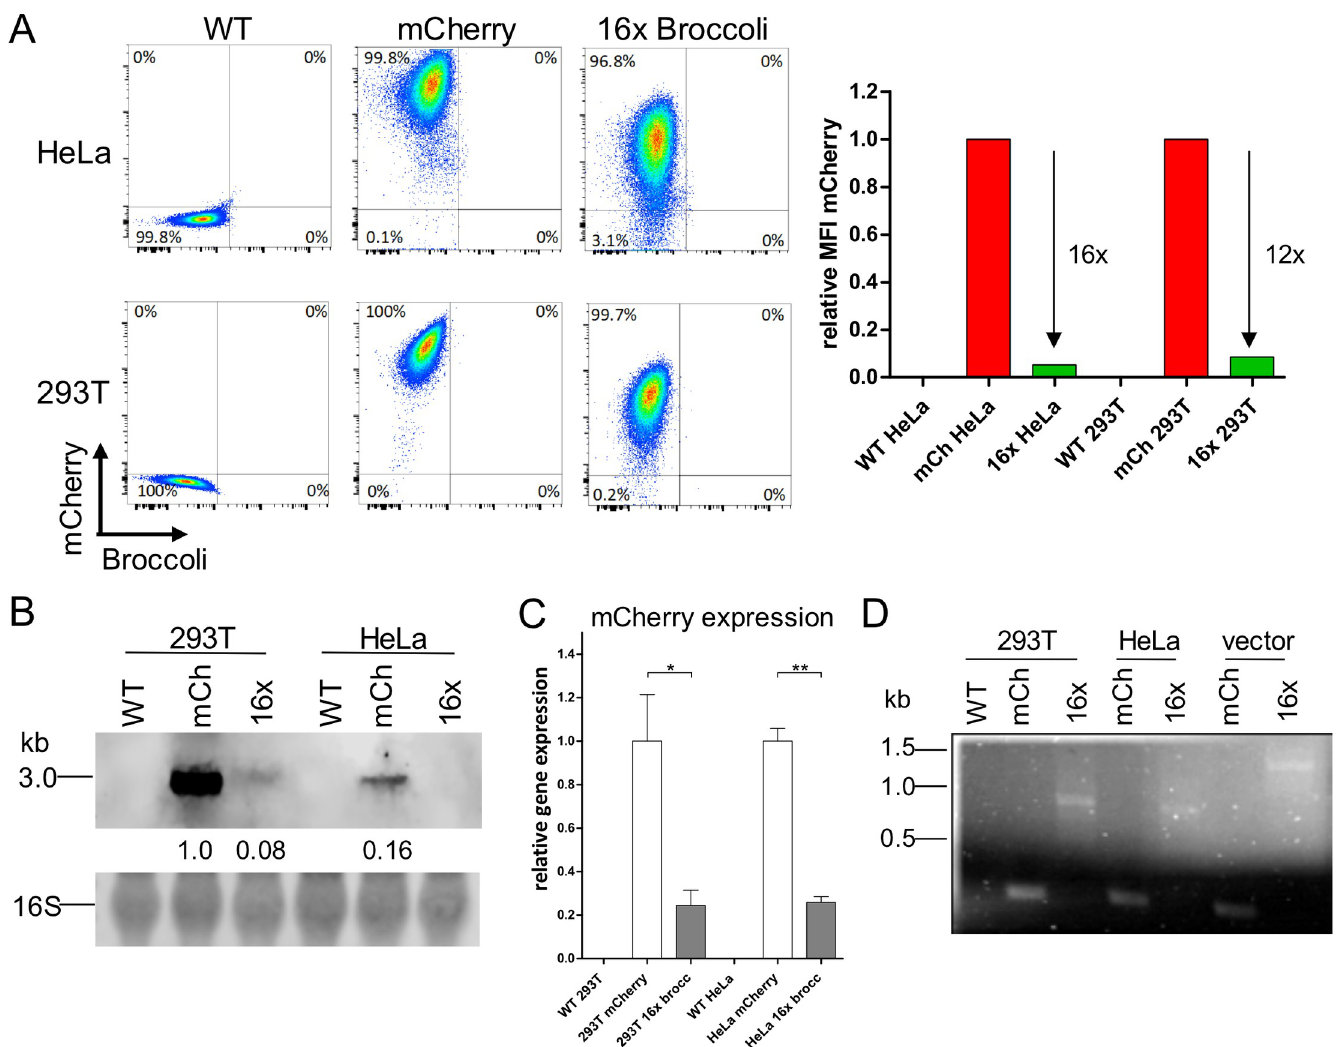
Fig 5. Polyclonal Broccoli-expressing cell lines showed reduced mCherry expression and no detectable Broccoli fluorescence. (A) Flow cytometry measurement of mCherry intensity in WT, mCherry or 16xBroccoli 293T or HeLa cells. (B) Northern Blot of mCherry RNA in the stable cell lines. RNA intensity was quantified and calculated relative to the 16S ribosomal band. All quantifications were further compared to the mCherry RNA in the mCherry-293T cells which was normalized to one. (C) RT-qPCR of mCherry. RNA was isolated from the stable cell lines, cDNA prepared and mCherry quantified by qPCR. Delta delta Ct of mCherry was calculated using GAPDH as the reference gene. Afterwards, all values were normalized to mCherry 293T cells. (D) Standard PCR for Broccoli from DNA isolated from 293T and HeLa cells expressing mCherry or 16x Broccoli (four lanes on the left side); lentiviral plasmid used for the generation of the mCherry and 16x Broccoli cell lines (two lanes on the right side). Contrast of gel image was optimized using the substract background function in Fiji (Fiji.sc). Statistical analysis performed by t-test (C). � P < 0.05, �� P < 0.01.